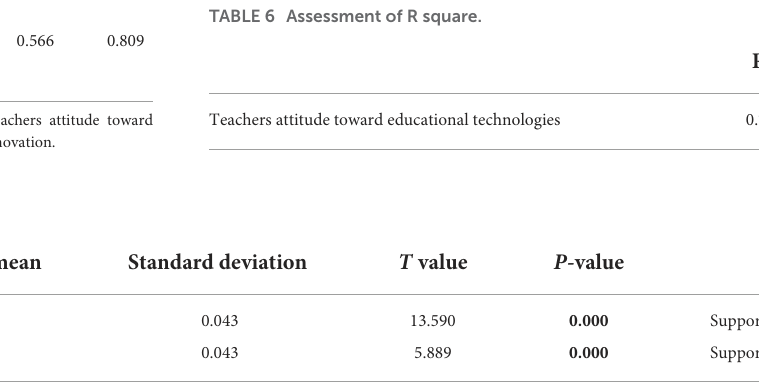
TABLE 6 Assessment of R square.